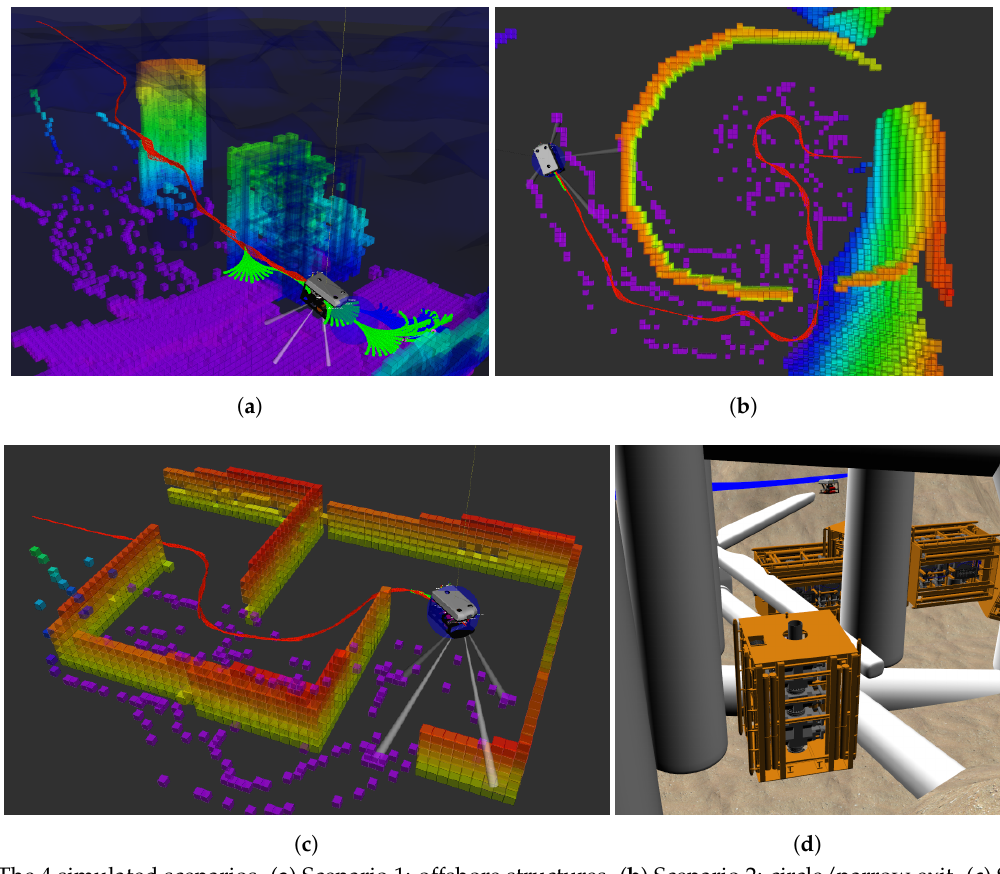
Figure 8. The 4 simulated scenarios. ( a ) Scenario 1: offshore structures. ( b ) Scenario 2: circle/narrow exit. ( c ) Scenario 3: corridor. ( d ) Scenario 4: incident/cluttered. ( a – c ) The OctoMap constructed from the data of the forward looking sonar throughout the execution of the plan (red trajectory). ( d ) Shows the Gazebo world using the UUV Simulator, where the robot needs to navigate in a cluttered environment through fallen wind turbines, pillars and other offshore structures. The robot is depicted at the end of the query in all of the